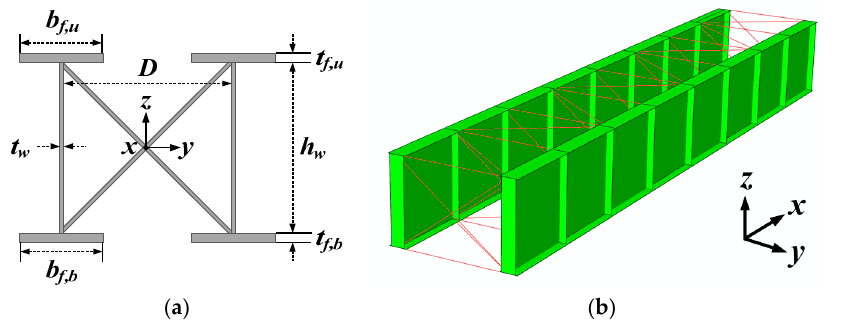
Figure 8. Open-deck steel plate girder bridge: ( a ) section dimensions and ( b ) 3D modeling. Table 3. Dimensions of a typical open-deck plate girder bridge.